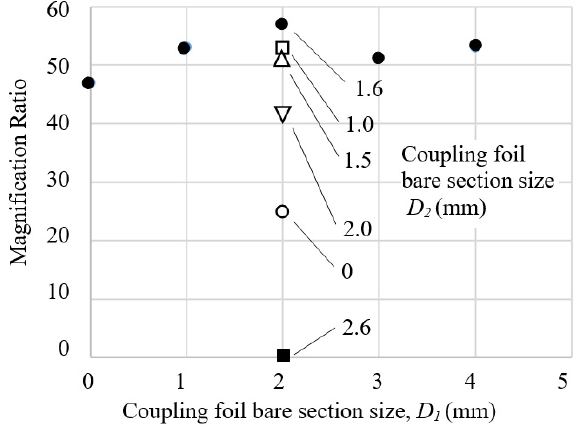
Figure 7. Effect of the sizes of bare sections of the coupling foils on the total magnification ratio of the conceptual design B of Figure 6a.